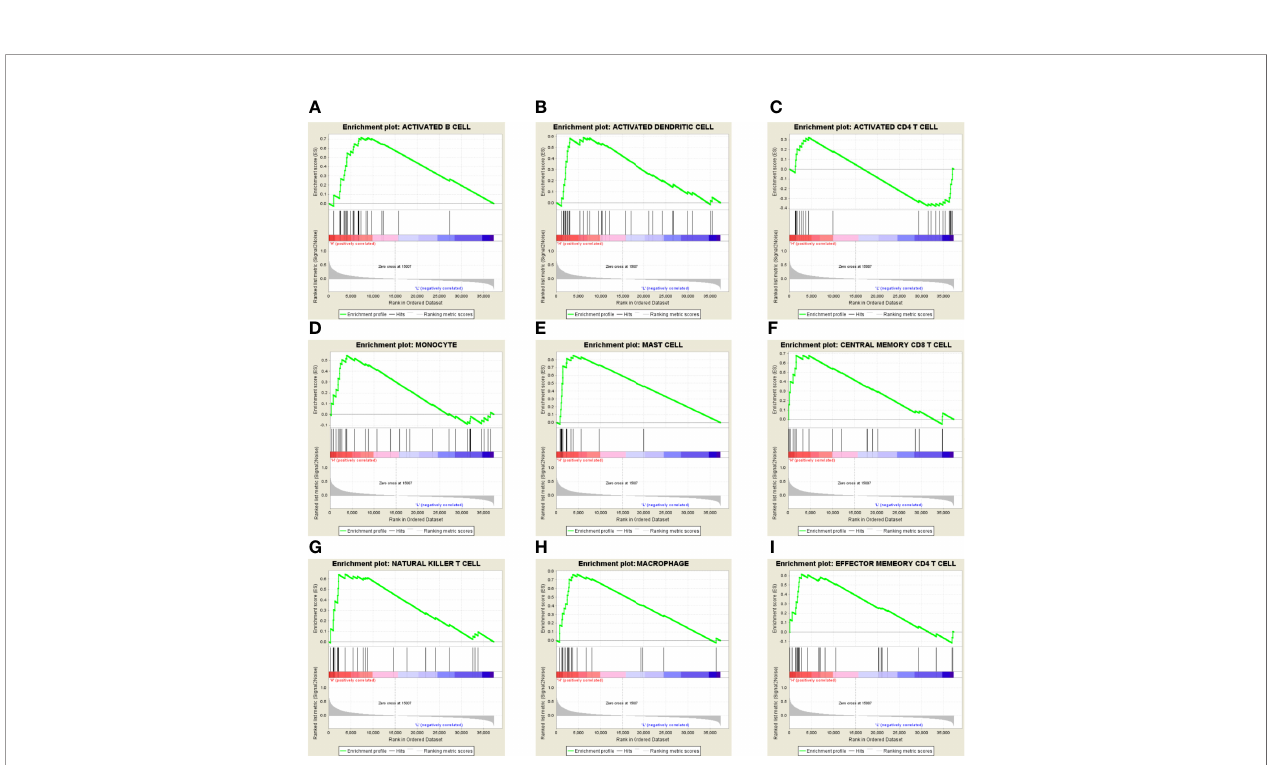
FIGURE 8 | (A – I) In the GSEA database, GPX8 was positively correlated with B cells, dendritic cells, CD4+ T cells, CD8+ T cells, macrophages, mast cells, monocytes, natural killer cells,